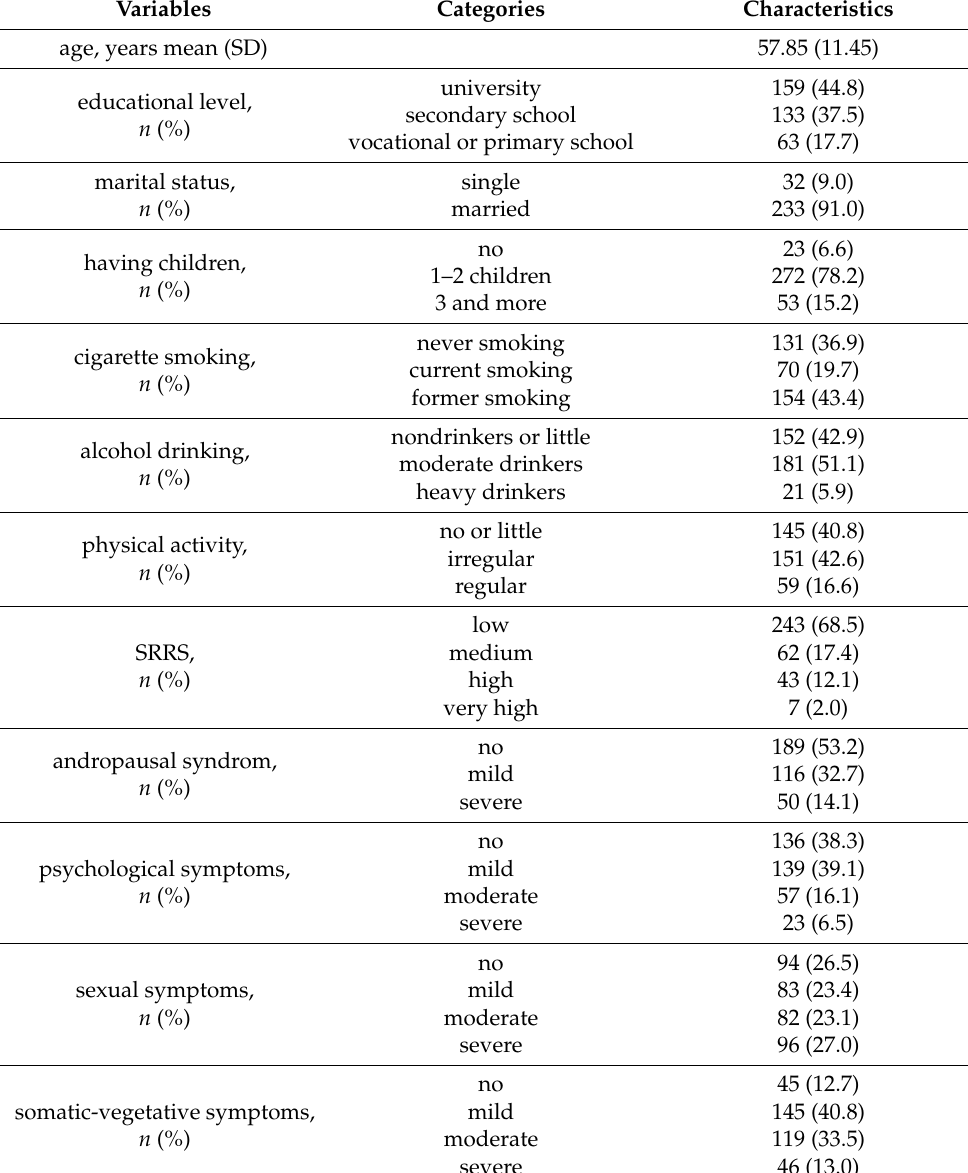
Table 1. The distribution of background characteristics for men from